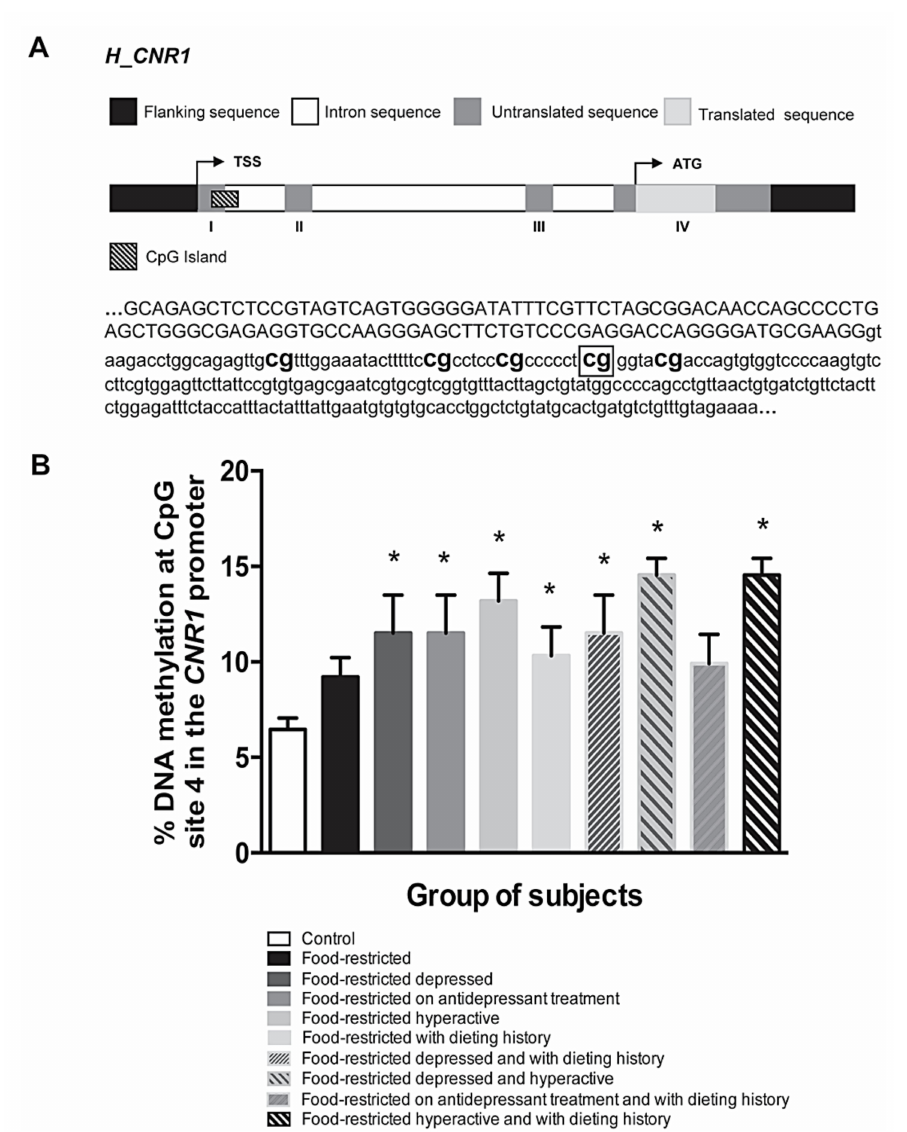
Figure 2. ( A ) Representation of human CNR1 gene and sequence of CpG islands (human GRcH38: crh 6:88165719-88165820) studied for DNA methylation. Flanking sequences are marked in black, UTRs in dark gray, coding regions in light gray, introns in white and CpG islands in lined pattern. Position of ATG, TSS and exons are also reported. Bold text indicates the CpG sites analyzed; framed CG indicates the CpG site number 4. ( B ) DNA methylation status at the CpG site number 4 in the sequence of the human CNR1 gene under study in food-restricted subjects stratified based on the co-occurrence of different environmental factors. The bars represent the mean of the % of DNA methylation ± the SEM in the different subgroups. Significant differences are indicated as * p < 0.05 vs. Control